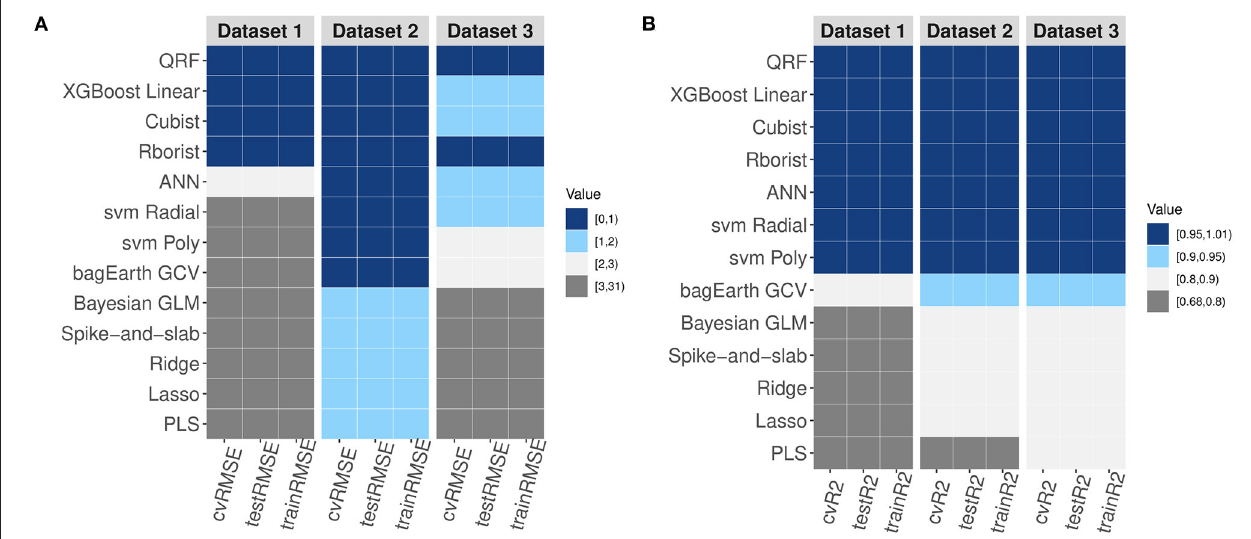
R 2 = 0.716, than Dataset 3 , which performs well with the same model, with RMSE = 3.579 nmol · min − 1 and R 2 =